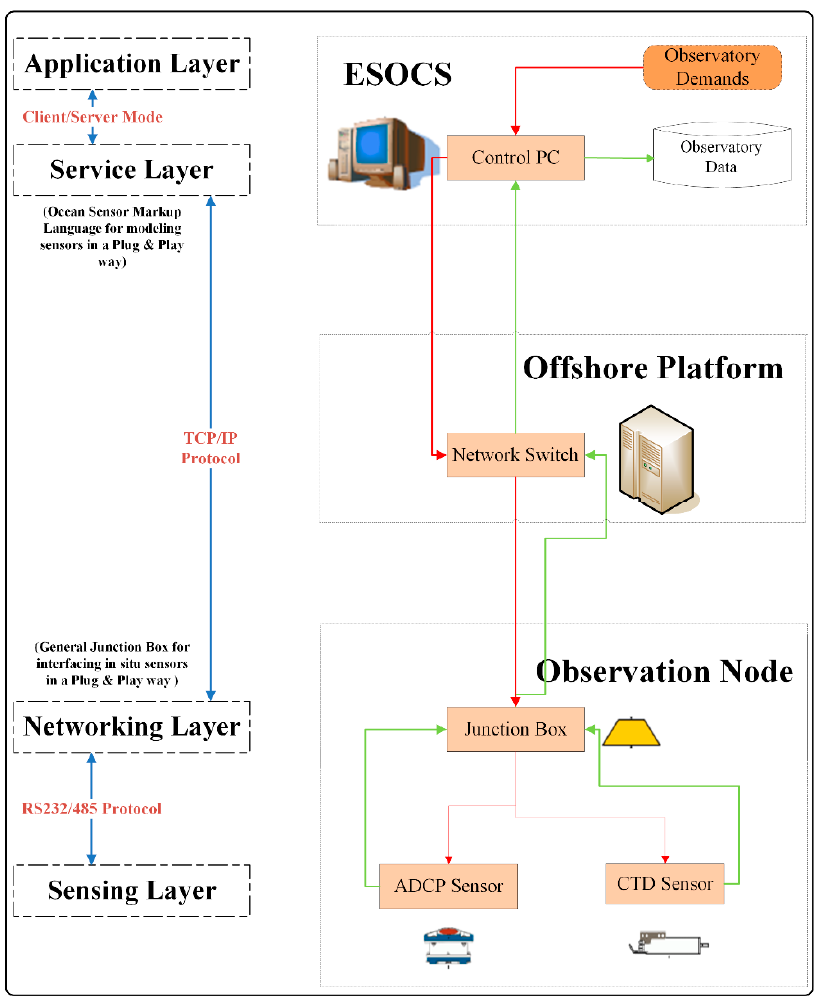
Figure 5. Monitoring Architecture for ESOCS.